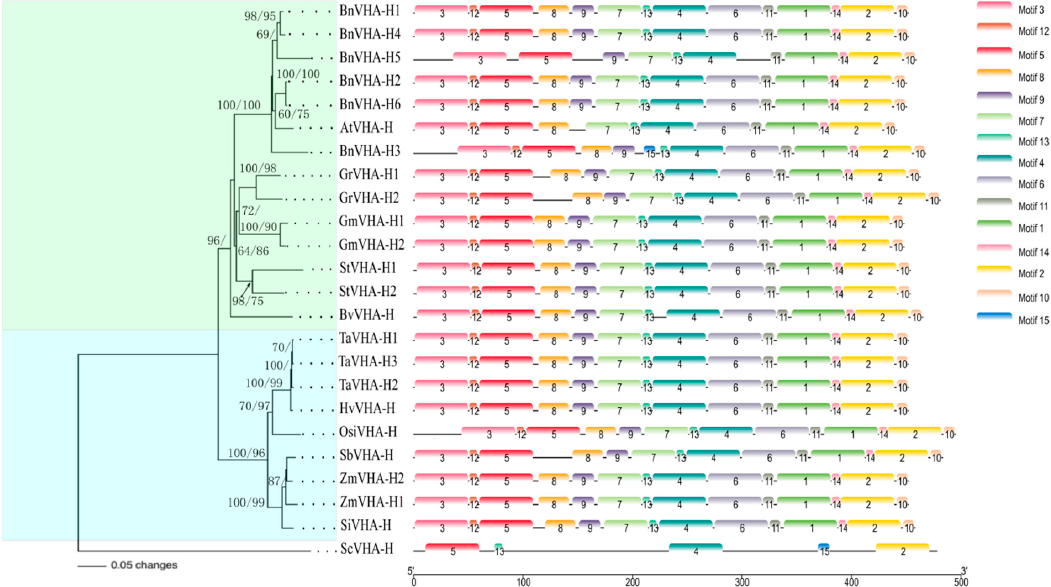
Figure 2. The neighbor-joining tree and motif compositions of the 24 VHA-H genes from 12 species of plants and yeast ( Saccharomyces cerevisiae , ScVHA-H ), which was used as outgroup. The green and blue backgrounds on the tree indicate the clades of dicots and monocots, respectively. Bootstrap values based on 1,000 replicate analysis and the values of the posterior probability based on Bayesian analysis separated by forward slashes are given on the branches. The bar on the bottom left indicates 0.05 base differences per amino acid position. A total of 15 motifs represented by color bars are revealed on the 24 VHA-H genes. The ruler on the bottom right displays the location information of each motif on the amino acid chain.